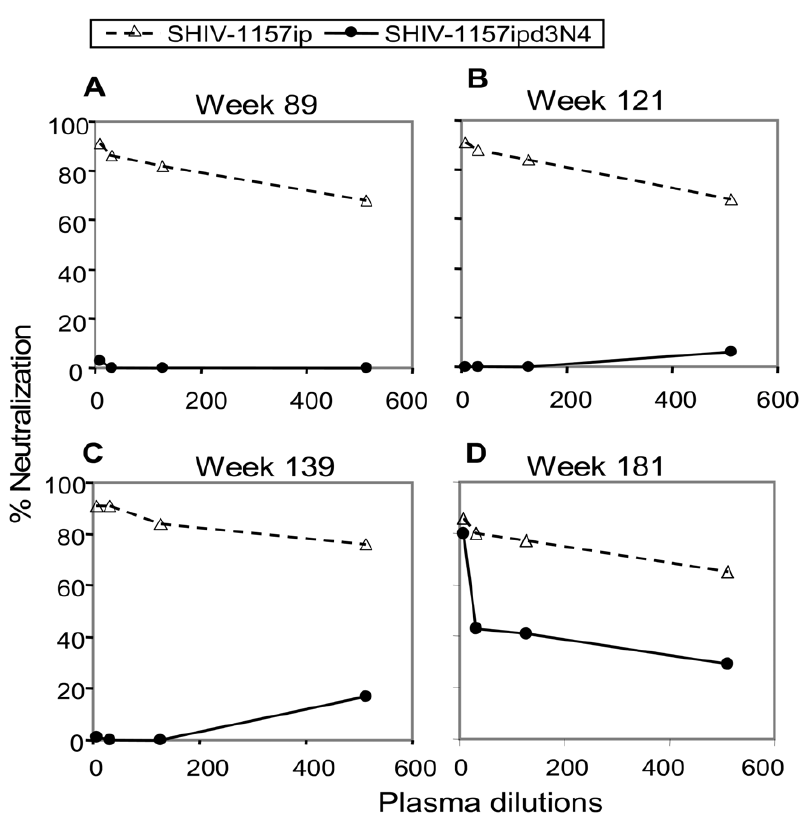
Figure 1. Selection of a neutralization escape variant in rhesus monkey RPn-8. This monkey was inoculated initially with an ‘‘early’’ form of the virus (the parental infectious molecular clone, SHIV-1157i; see Table 1), and 4 weeks after RPn-8 had progressed to AIDS ( , 2.7 years), the ‘‘late’’ virus, SHIV-1157ipd3N4 [1], was generated by molecular cloning of the 3 9 proviral half from RPn-8 PBMC DNA. Neutralization of SHIV-1157ip (‘‘early’’ strain, open triangles) and SHIV-1157ipd3N4 (‘‘late’’ strain, closed circles) with autologous plasma from animal RPn-8 at the time points post- inoculation indicated is shown (A–D), including contemporaneous plasma for the ‘‘late’’ virus collected at week 139 (panel C). Virus (grown in RM PBMC) was incubated with different dilutions of monkey plasma for 1 h before being added to TZM-bl cells in the presence of DEAE-dextran. Luciferase expression was measured on day 2 post-infection.